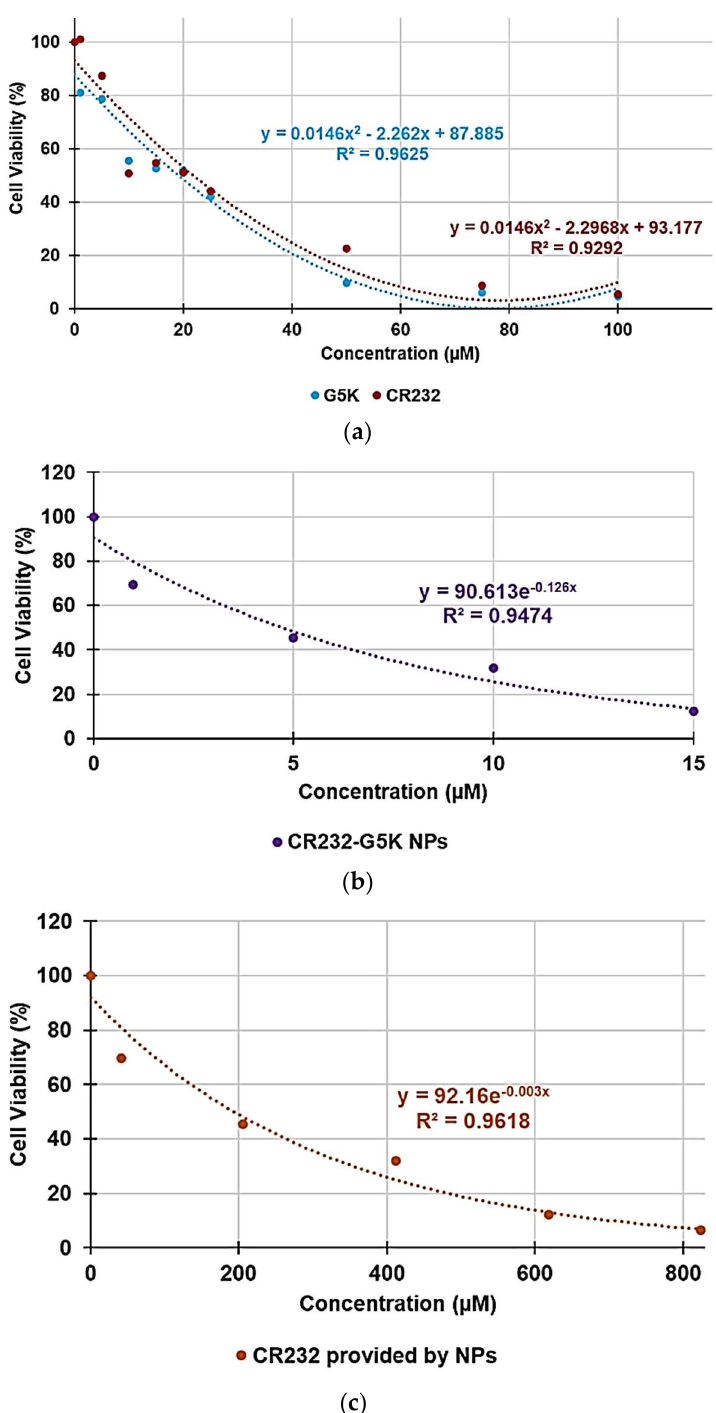
Figure 3. Regression models that better fit the dispersion graphs obtained when reporting the cell viability % vs. the concentration of samples at 24 h of exposure of CR232 and G5K in graph ( a ) of CR232-G5K NPs ( b ) and of the nano-formulated CR232 provided by the quantity of NPs administered ( c ).